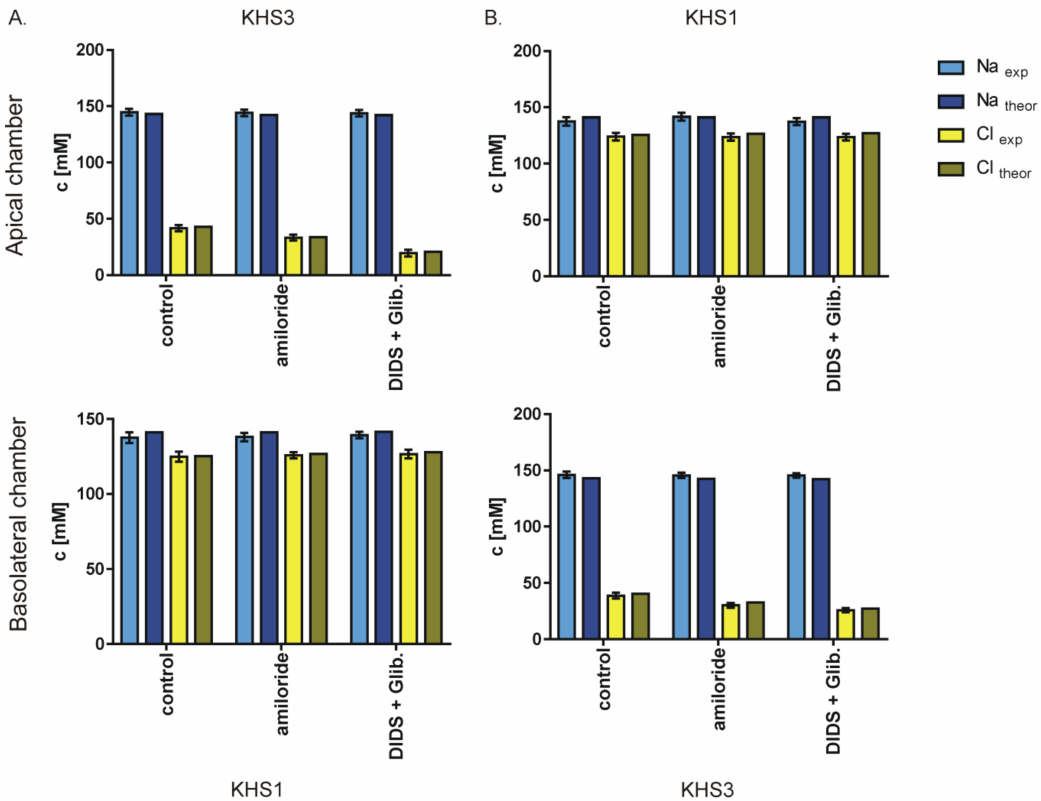
Figure 8. Measured (Mean ± SD) and theoretically predicted concentrations of sodium and chloride ions on both sides of the cell layer in control conditions after blocking particular ion channels present on the apical side of the monolayer. The experiments with sodium gradients and isosmotic flow of x fraction of 145 mM sodium chloride across the epithelial cell monolayer are